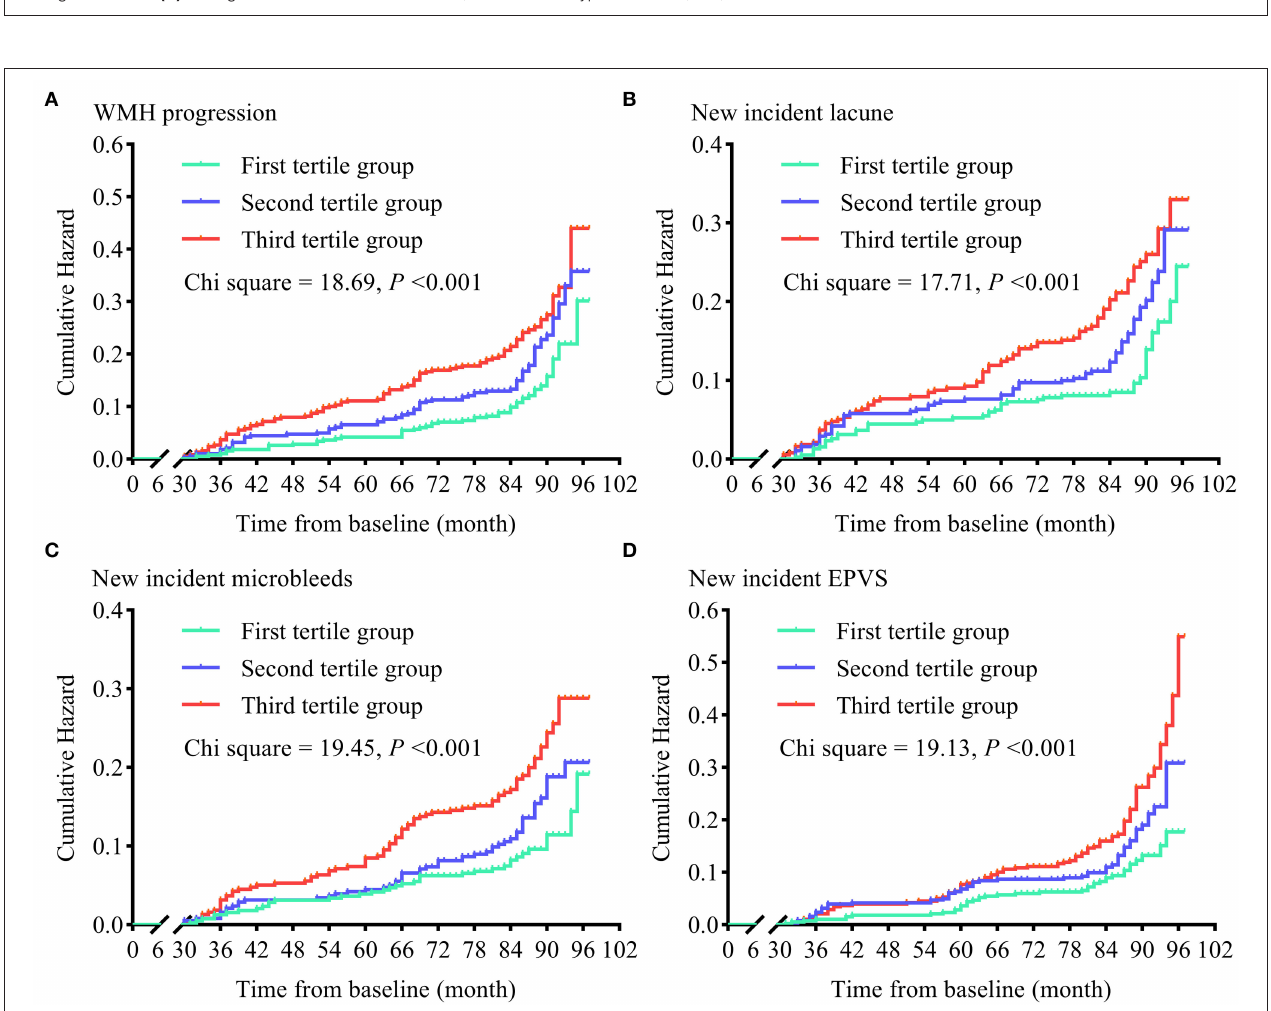
FIGURE 2 | Cumulative hazards of cerebral small vessel disease progression in tertile groups stratified by visit-to-visit mean sdLDL during the follow-up period. (A) Cumulative hazards of WMH progression. (B) Cumulative hazards of new-incident lacunes. (C) Cumulative hazards of new-incident microbleeds. (D) Cumulative hazards of new-incident EPVS. WMH, white matter hyperintensities; EPVS, enlarged perivascular space.